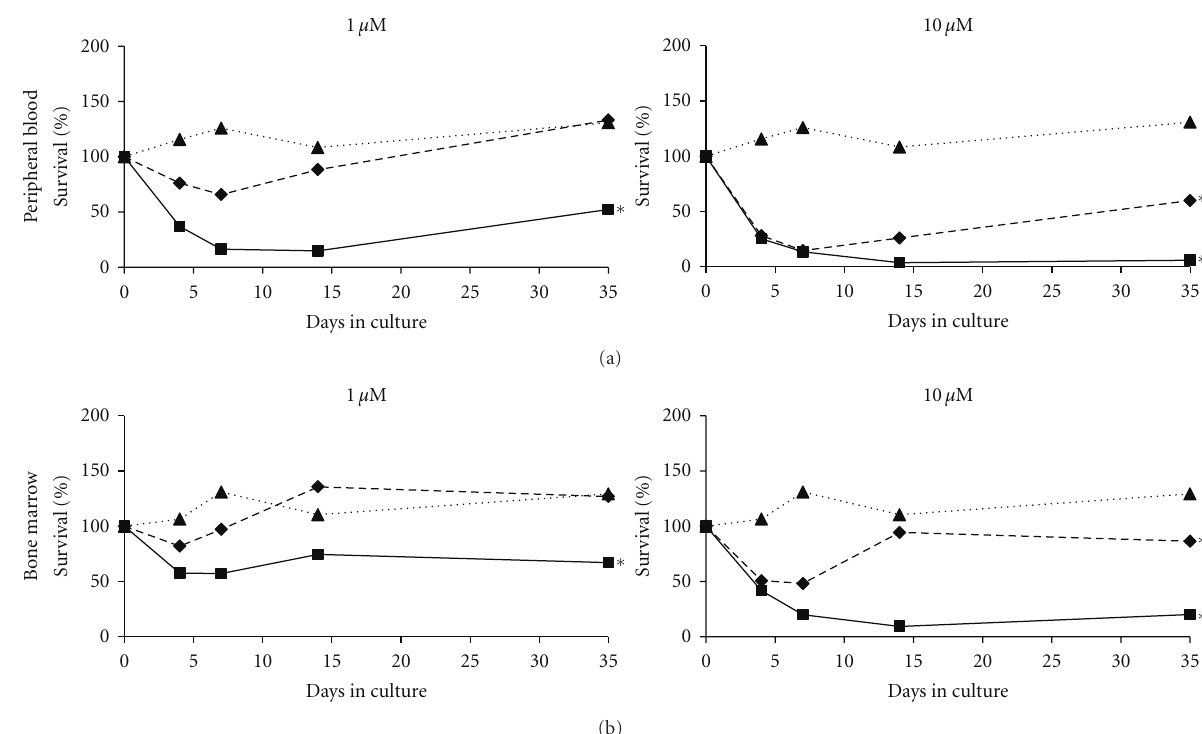
Figure 5: Growth of AML MNC ± drug treatment. Growth of untreated ( ... . dotted line), Ara-C treated (- - - dashed line) or CNDAC treated (— solid line) (a) PB and (b) BM AML cells from patients over the 35 day culture period, plotted as % survival relative to the number of cells initially plated. Drug treatment concentrations plotted are at 1 μ M and 10 μ M. ∗ denotes P ≤ 0.05 as determined by the log rank test as compared to the survival curve of untreated